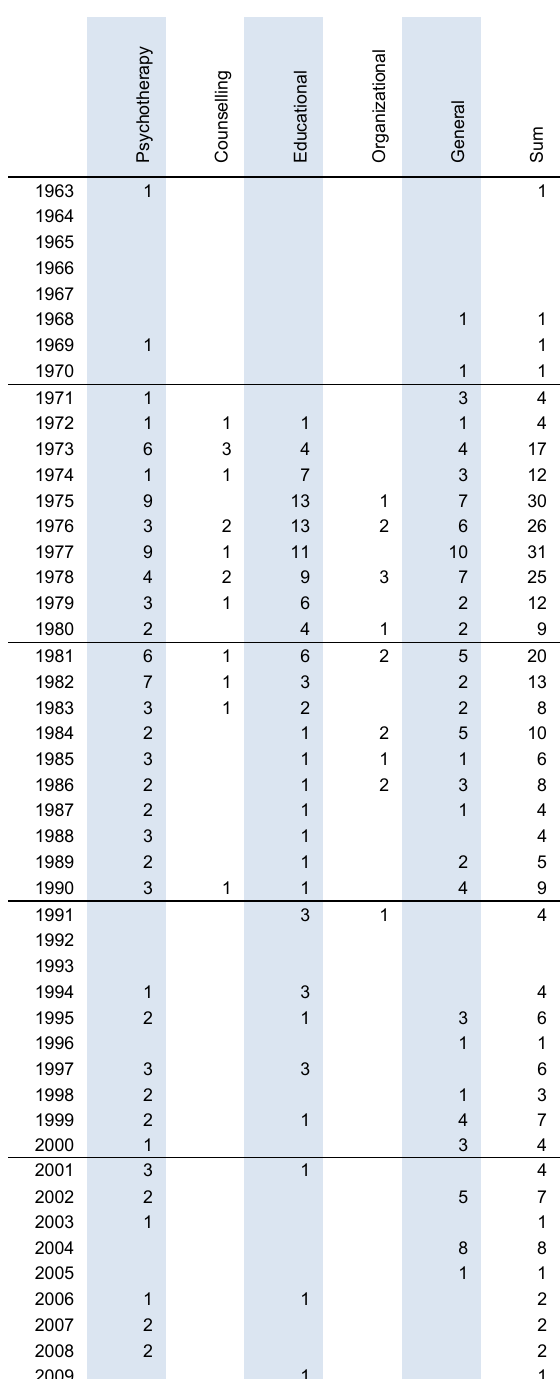
Table 1. The Big List - TA research studies per application field and